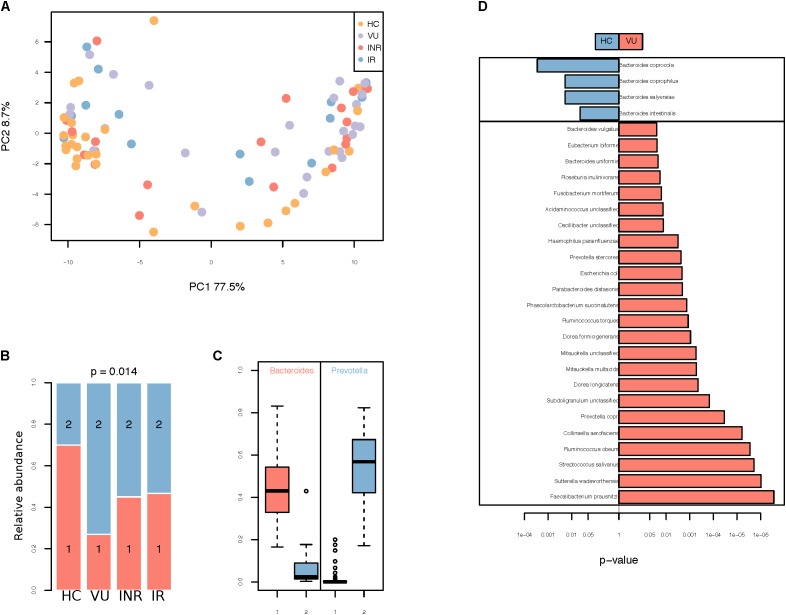
(A) Principal coordinates analysis (PCoA) using Bray–Curtis dissimilarity distance. (B) Distribution of VU, IR, INR, and HC in enterotypes. The areas of the columns scale with sample size, that is, n = 26, 20, 15, and 30, respectively. (C) Relative abundances of Bacteroides and Prevotella in the two community types. (D) Relative abundance of species different between VU and healthy groups. Only the median relative abundances greater than 0.1% of total abundance are included (FDR < 0.1, Wilcoxon rank-sum test corrected by the Benjamini and Hochberg method).